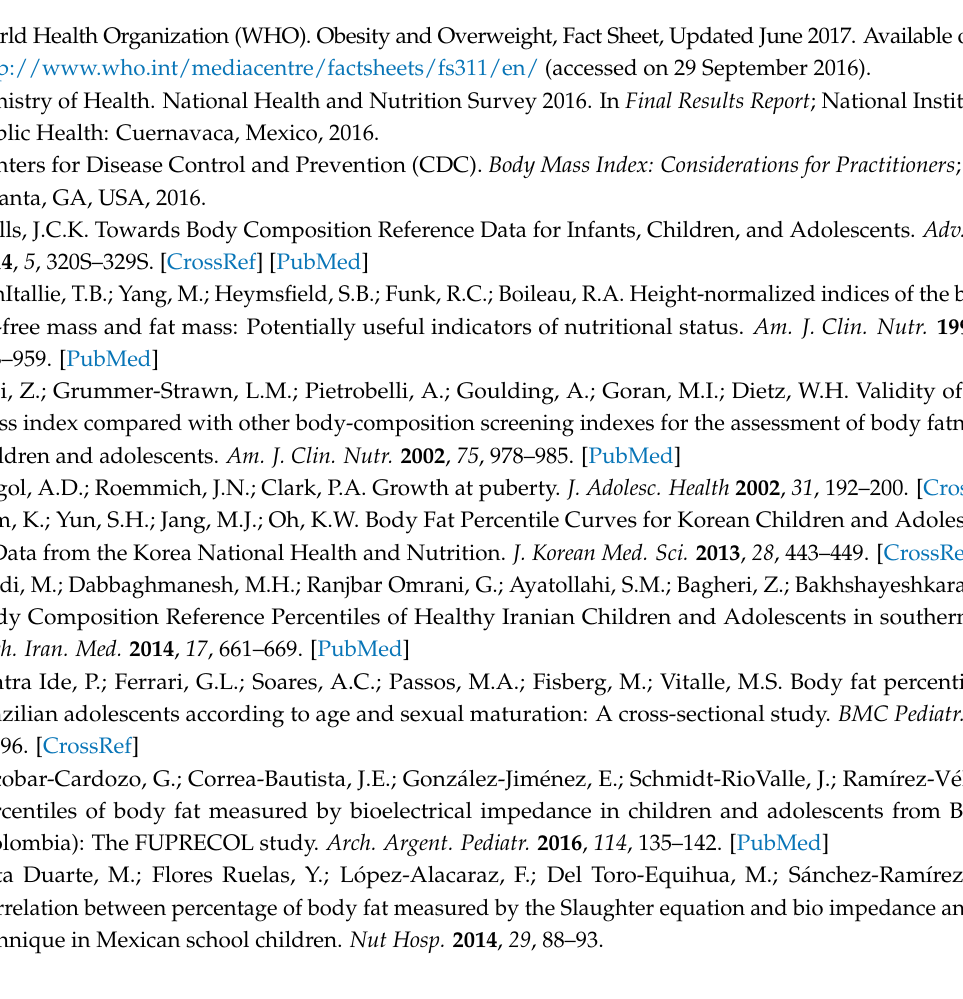
Figure S1: Distribution of the study population from six primary schools in Mexico City. Table S1: Smoothed LMS percentiles of BMI by age and gender; Table S2: Smoothed LMS percentiles of fat percentage measured by skin fold thickness Slaughter equation by age and gender; Table S3: Smoothed LMS percentiles of FFM% by age and gender; Table S4: Smoothed LMS percentiles of FMI by age and gender; Table S5: Smoothed LMS percentiles of FFMI by age and